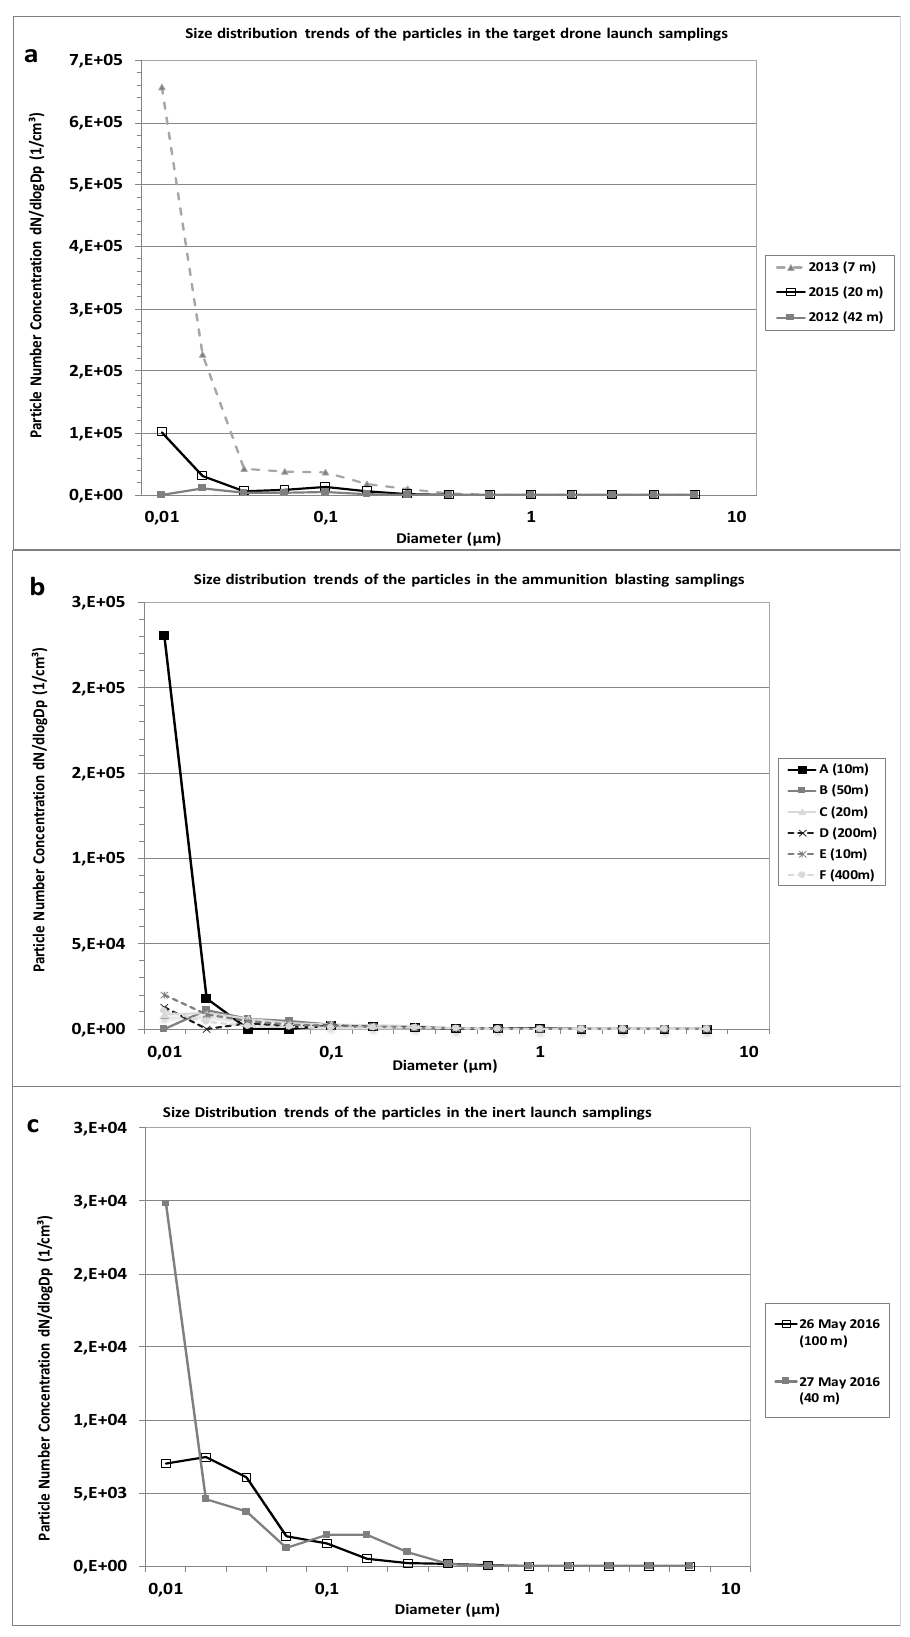
Figure 5. Size distribution patterns during the target drone launches ( a ), ammunition blasting campaign ( b ) and inert launches ( c ).